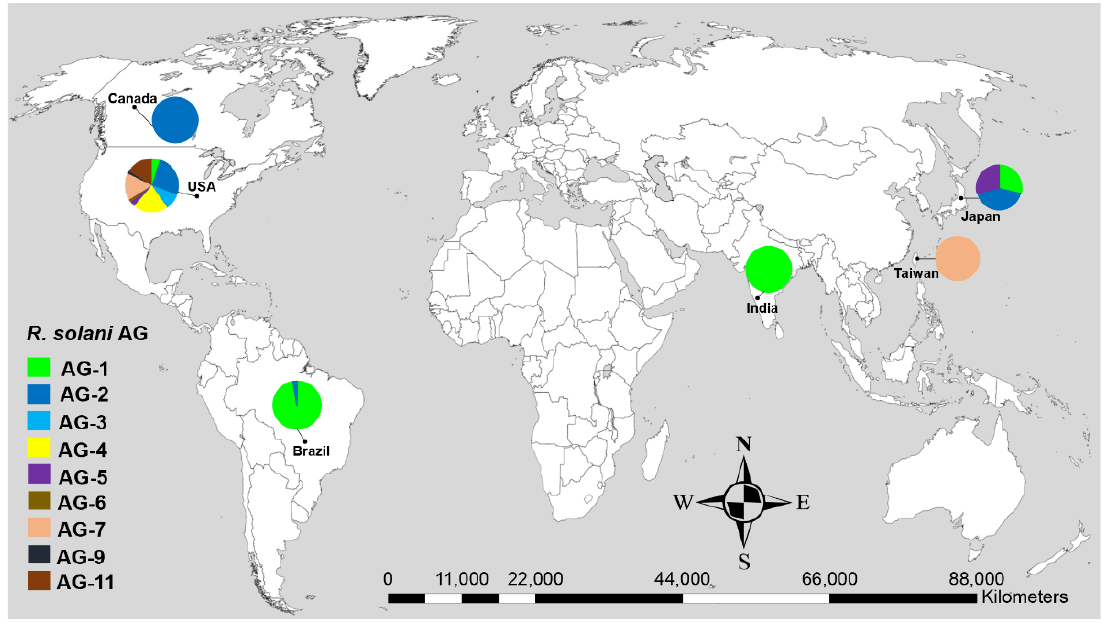
Figure 1. Geographical distribution of R. solani anastomosis groups (AG) associated with soybean with known sequences in GenBank. Data in pie charts indicate the number of AG reported in each geographical origin.